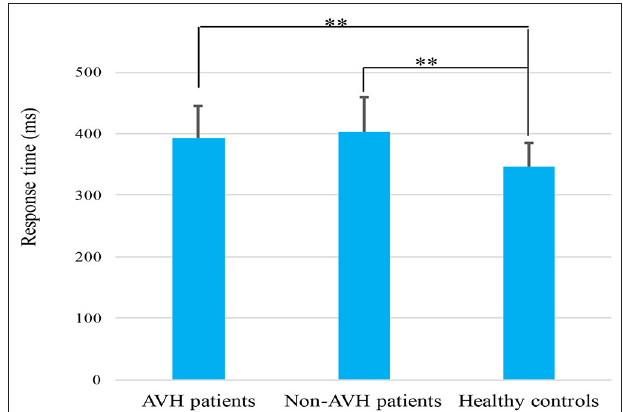
FIGURE 1 | Mean response time elicited by correct Go trials in AVH patients, non-AVH patients and healthy controls. Error bars denote the standard error. ** p <